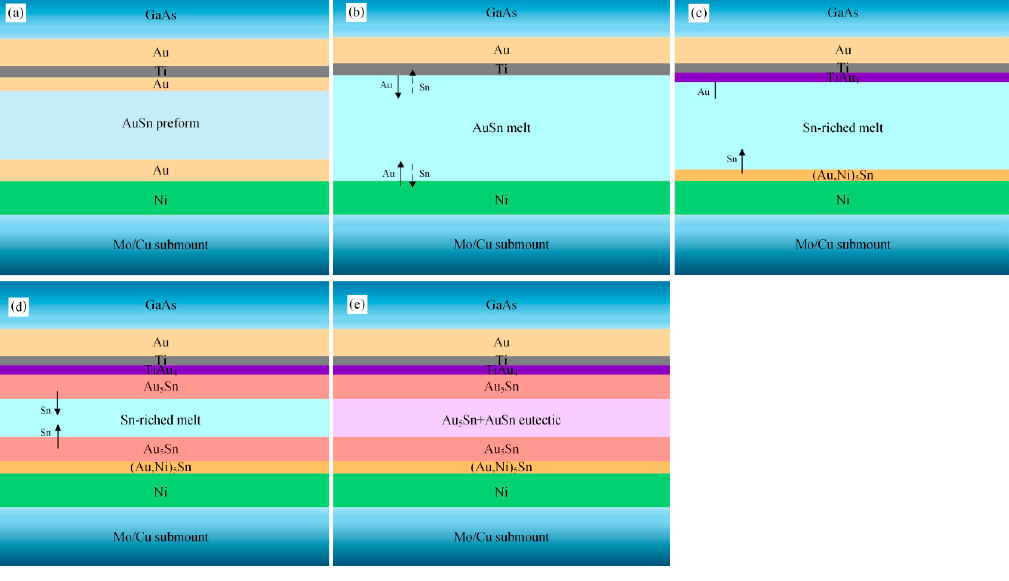
Figure 12. The MMIC sample in Figure 11a separated by “hot-lifting.” Figure 13. EDS analysis of the soldered MMIC after separation: ( a ) wetted area and ( b ) unwetted area. 4. Conclusions GaAs MMICs with different back metallization systems (TiW/Au and Au/Ti/Au) were Au-Sn eutectic bonded in the mass production. The microstructure characterization and interfacial reactions during the bonding process were studied to ascertain the formation mechanism of the edge breakage and excessive voids. 1.